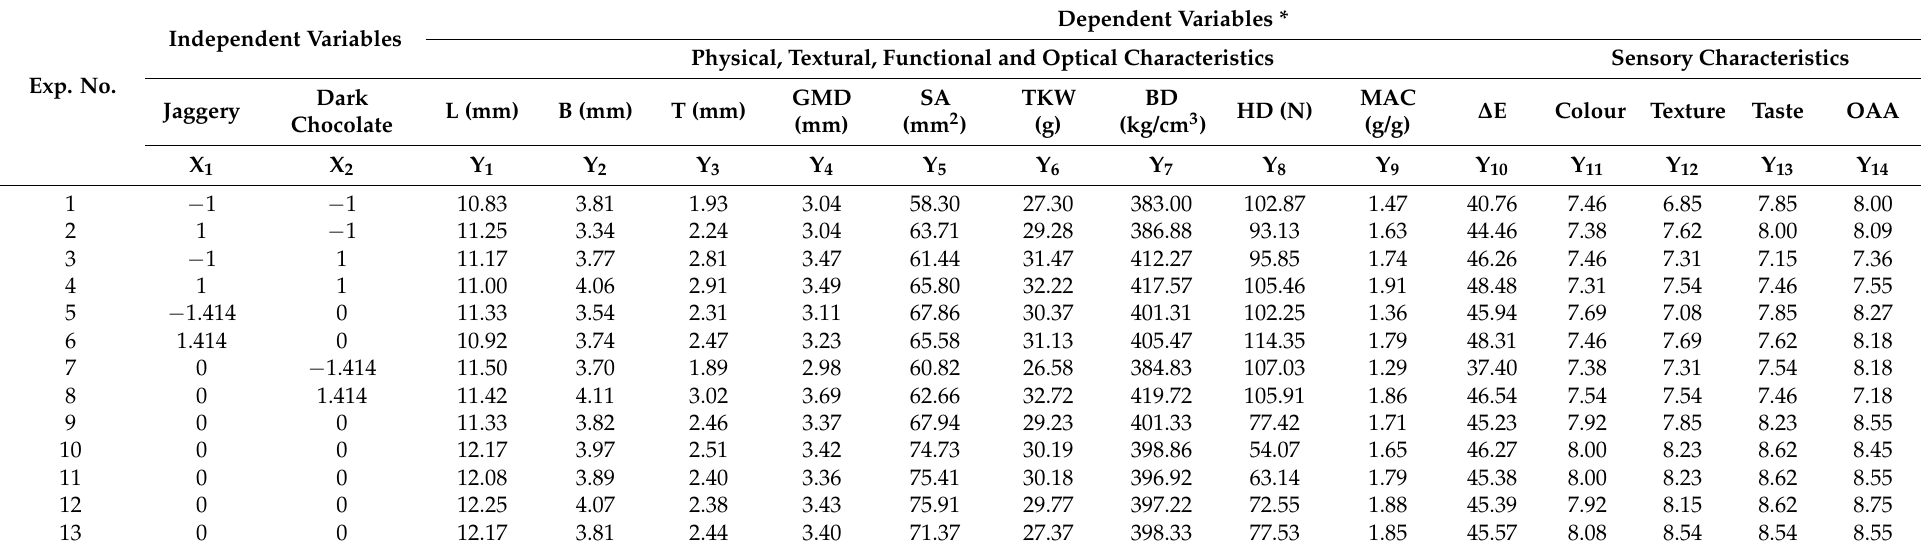
Table 2. Physical, textural, functional, and optical sensory characteristics of CCRFR as affected by the levels of jaggery and chocolate.